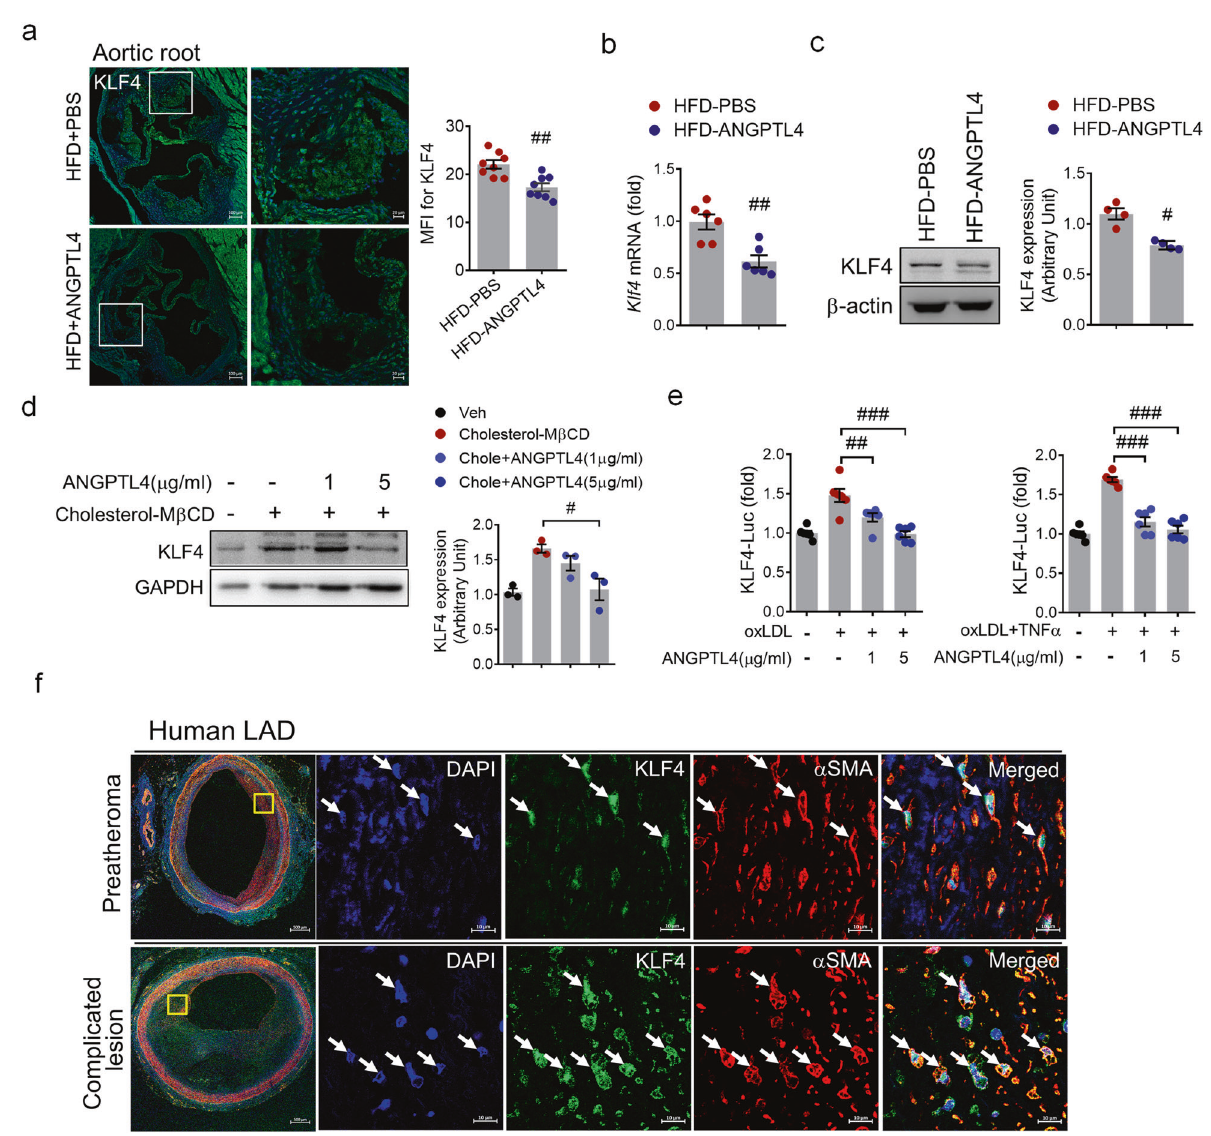
Fig. 6 Attenuation of KLF4 upregulation by ANGPTL4 in atherosclerosis. a Expression of KLF4 within the plaque of the aortic root from the two groups was determined by immuno fl uorescent staining. Data were the mean fl uorescence intensity (MFI) of KLF4 (mean ± SEM, n = 8). Scale bar, 20 μ m. b , c Aortic SMCs were isolated from atherosclerotic Apoe − / − mice treated with PBS or ANGPTL4, and the level of KLF4 was measured. The levels of KLF4 mRNA ( b ) and protein ( c ) were lower in the ANGPTL4 group than in the PBS group. d Western blotting of KLF4 expression in SMCs from Apoe − / − mice pretreated with ANGPTL4 for 24 h and then stimulated with cholesterol (10 μ g/ml) for 72 h. e KLF4 promoter activity was increased in human aortic SMCs stimulated by oxLDL (10 μ g/ml) or oxLDL and TNF α (100 ng/ml) for 24 h but was inhibited by ANGPTL4 (1, 5 μ g/ml) treatment. f Representative images of α -SMA + KLF4 + staining in preatheromatous plaques and complicated lesions of the human LAD. Scale bar, 10 μ m. Data were presented as the mean ± SEM. # p < 0.05, ## p < 0.01, ### p < 0.001 (by Student ’ s t -test or one-way ANOVA with Bonferroni ’ s multiple-comparisons test).